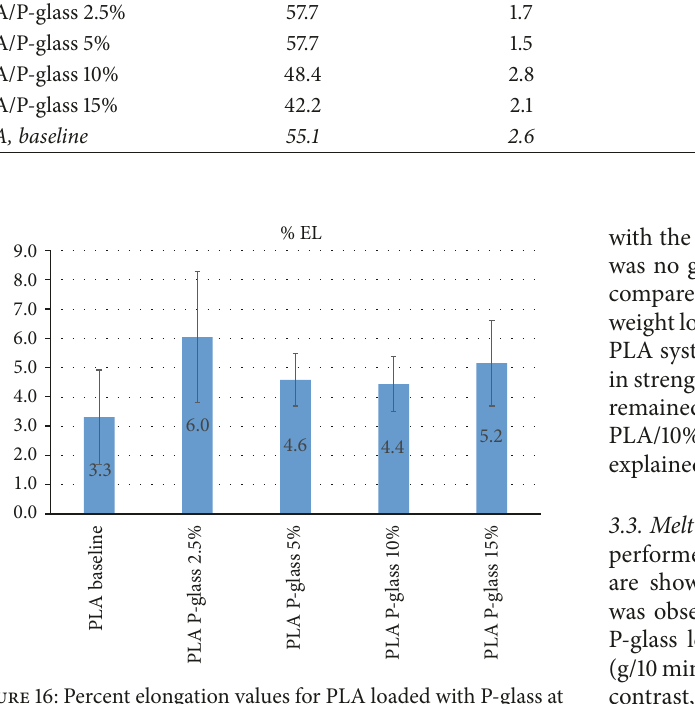
Figure 16: Percent elongation values for PLA loaded with P-glass at various weight